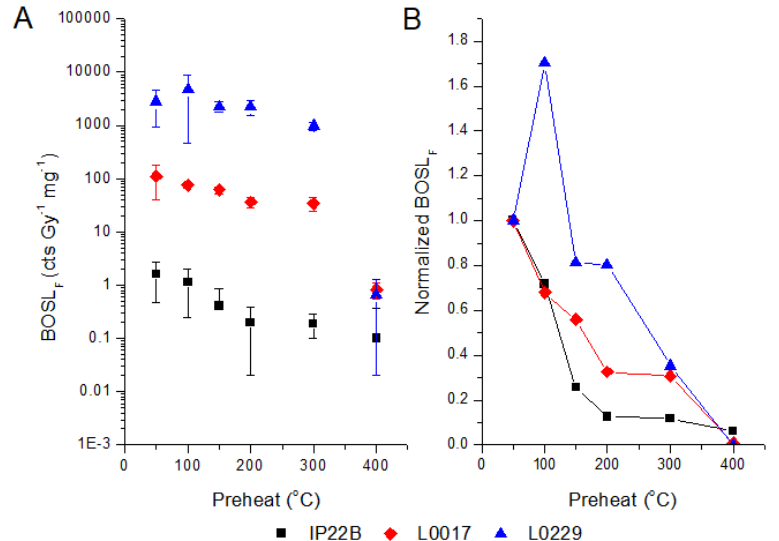
Figure 3. ( A ) Variation of BOSL F sensitivity (step 5 of Table 2), measured using preheat temperatures from 50 to 400 °C. ( B ) Variation of BOSL F sensitivity (preheat from 50 to 400 °C) normalized by the BOSL F sensitivity measured with preheat at 50 °C. Sensitivity values correspond to the average of three aliquots. Error bars are the standard deviation. Sample type is described in Table 1. BOSL F sensitivity values are shown in Table 6.